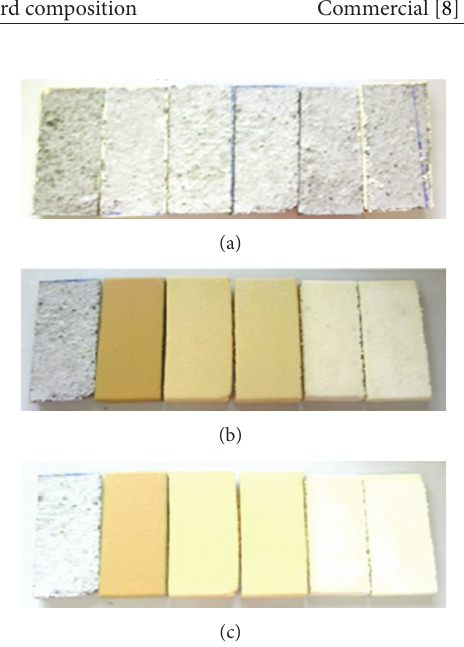
Figure 3: Samples of LC of (a) uncoated surface, (b) before being exposed to outdoor (sunlight and overnight humidity), and (c) after being exposed to outdoor (sunlight and overnight humidity).